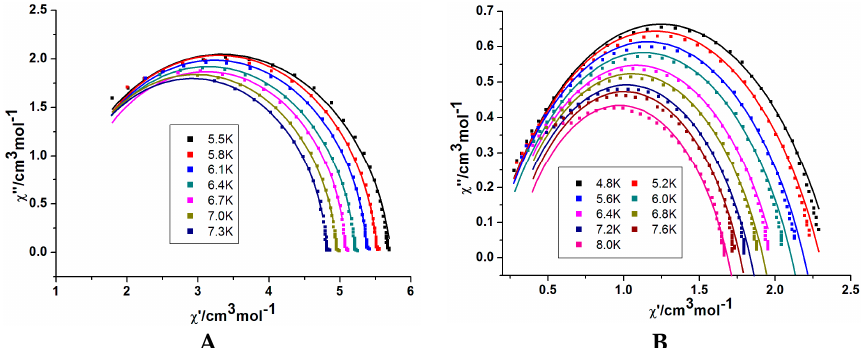
A B Figure 5. Plot of Cole-Cole for 1 ( A ) and 2 ( B ) at selected temperatures; Lines for fitting. Figure 5. Plot of Cole–Cole for 1 ( A ) and 2 ( B ) at selected temperatures; Lines for